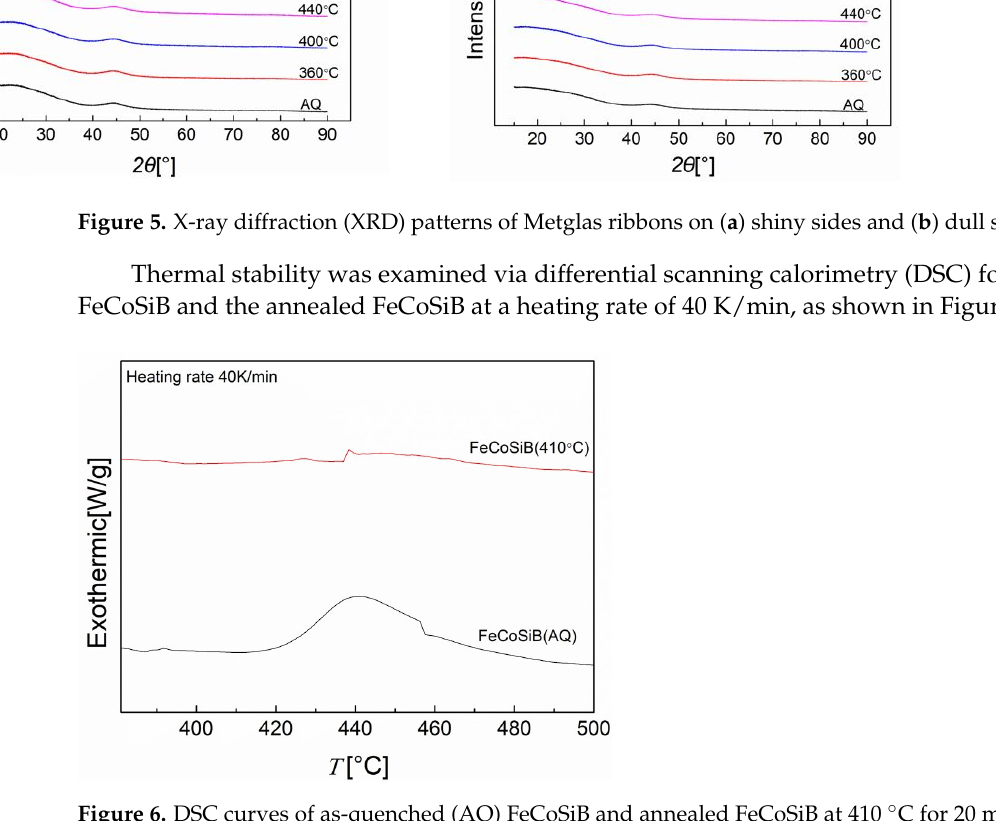
Figure 6. DSC curves of as-quenched (AQ) FeCoSiB and annealed FeCoSiB at 410 °C for 20 min.